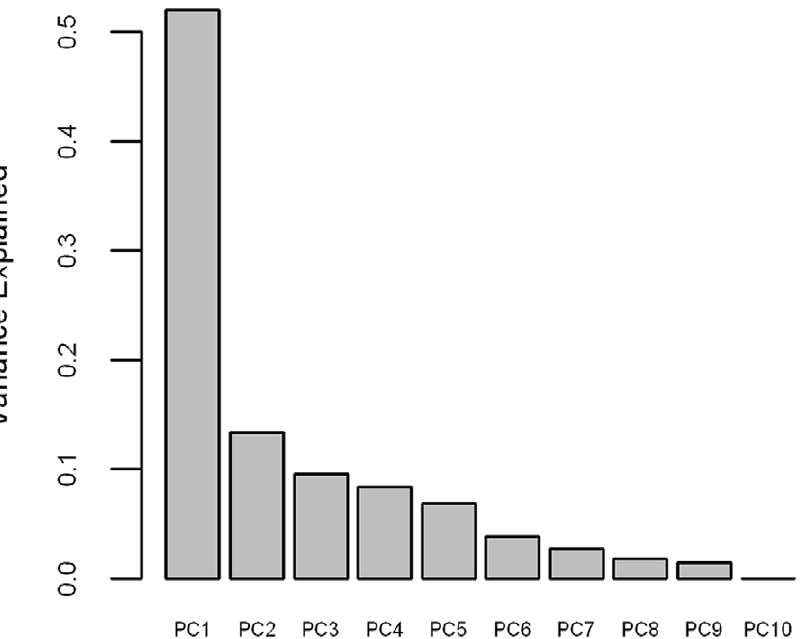
Figure 3. Proportion of variance explained. Proportion of variance in the original indicator dataset explained in by each principal component.